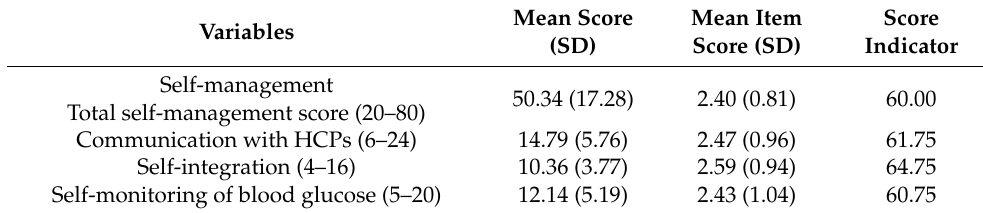
Table 2. Self-management, PCCQ scores in patients with